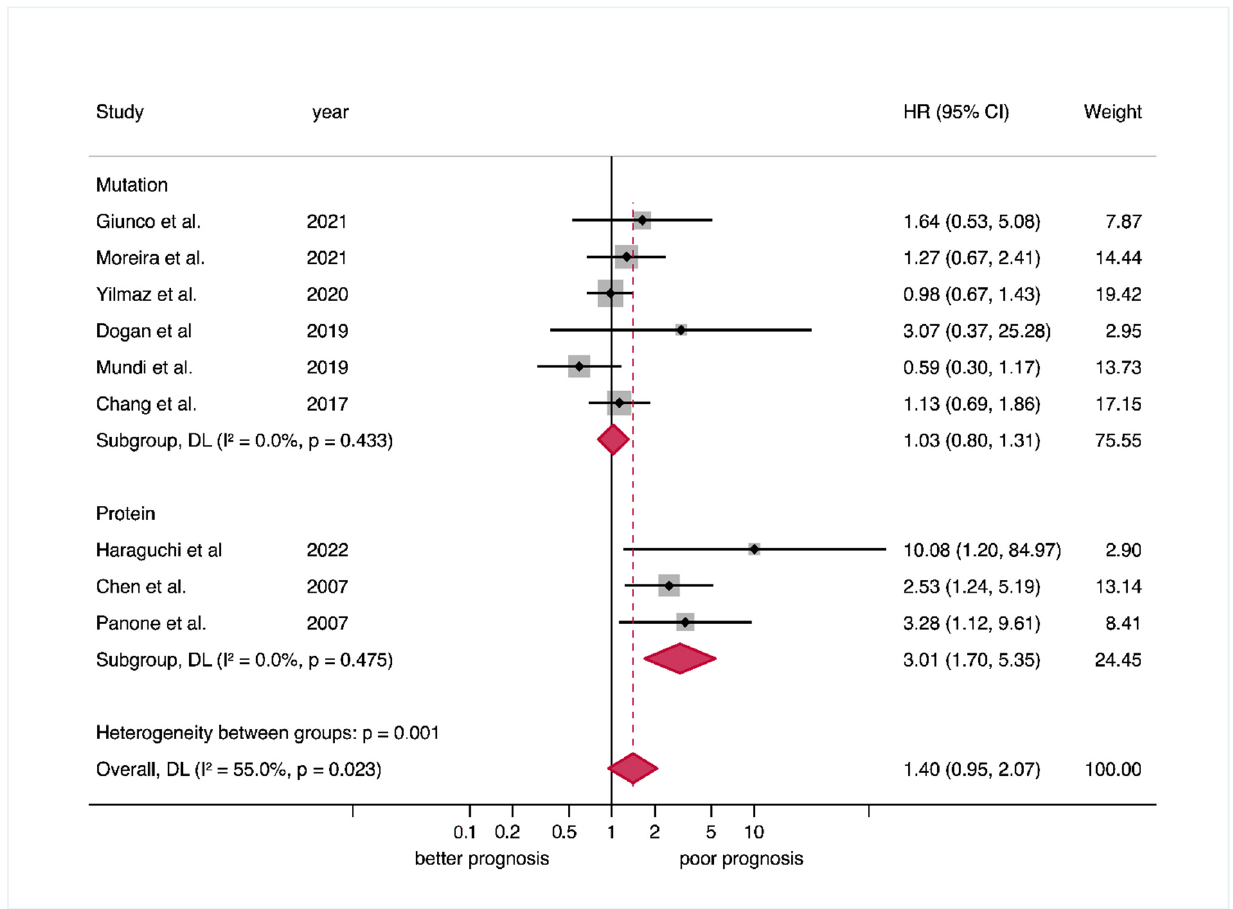
Figure 3. Forest plot graphically representing the meta-analysis on the association between TERT upregulation (stratified by alterations, i.e., gene mutations vs. protein overexpression) and OS in patients with OSCC. Random-effects model, inverse-variance weighting (based on the DerSimonian and Laird method). An HR > 1 suggests that TERT upregulation is associated with poor prognosis. Diamonds indicate pooled HRs with their corresponding 95% CIs. Abbreviations: TERT, telomerase reverse transcriptase; OS, overall survival; OSCC, oral squamous cell carcinoma; HR, hazard ratio; CI, confidence interval. Table 2. Meta-analyses of prognostic and clinicopathological significance of TERT upregulation in OSCC. Pooled Data